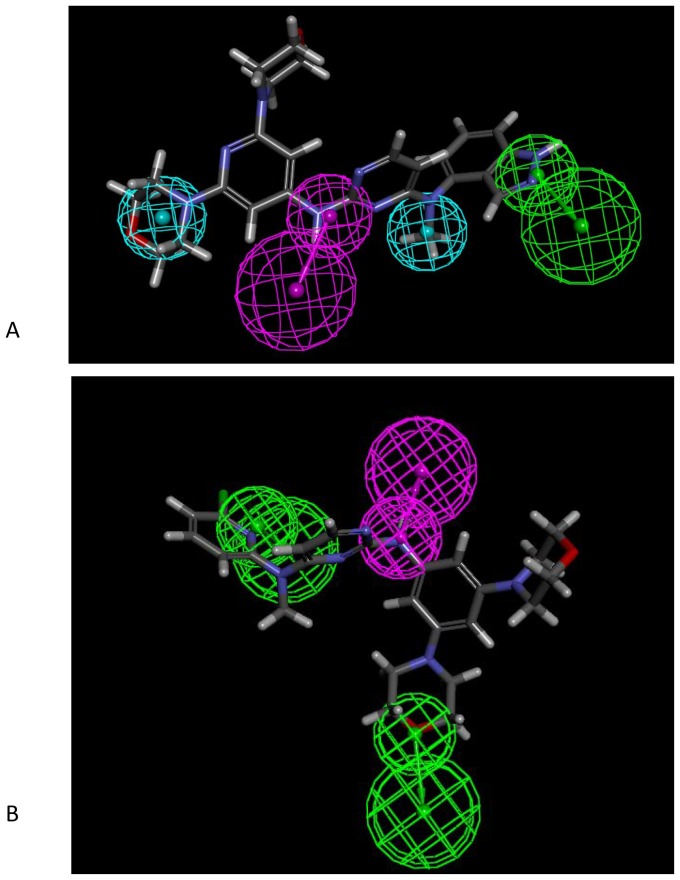
EphB4 ligand-based pharmacophores.(A) EphB4 pharmacophore derived using acoustic dispensing with 14 compounds. The most active compound (5, S1) is shown mapped. (B) EphB4 pharmacophore derived using tip-based dispensing with 14 compounds. The most active compound (w3, S1) is shown mapped. The pharmacophore features are hydrophobic (cyan), hydrogen bond donor (purple) and hydrogen bond acceptor (green).